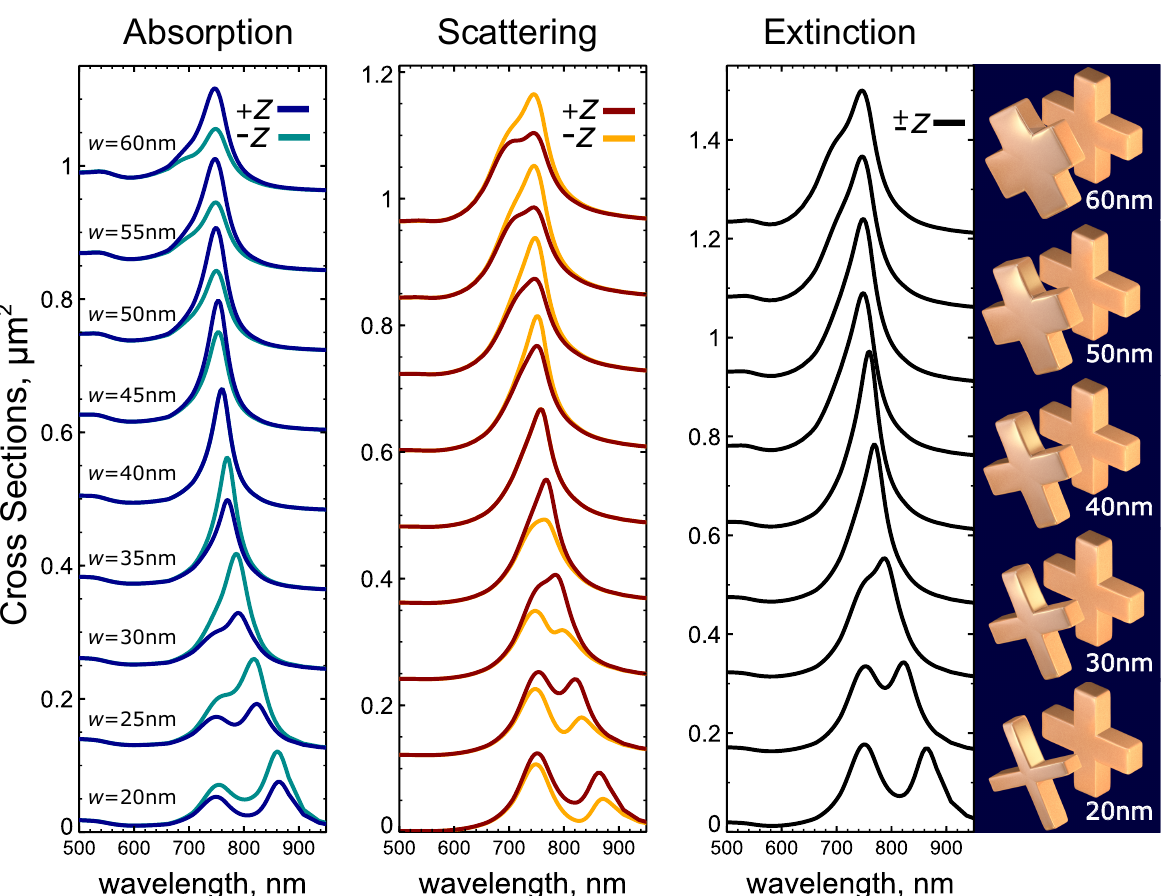
Figure 4. Simulation results for stacked gold nanocrosses, under excitation from circularly polarized plane waves given by propagation in either the + z or − z direction. The variation between right and left circular polarizations in the same propagation direction is negligible ( < 0 . 001 µ m 2 ) and making the associated curves overlapped here. The arm width, w , of one nanocross arm is varied from 20 to 60 nm, showing a significant difference in the absorption and scattering cross-section of reciprocal planewaves, provided the system does not have D symmetry. The calculation parameters are given in